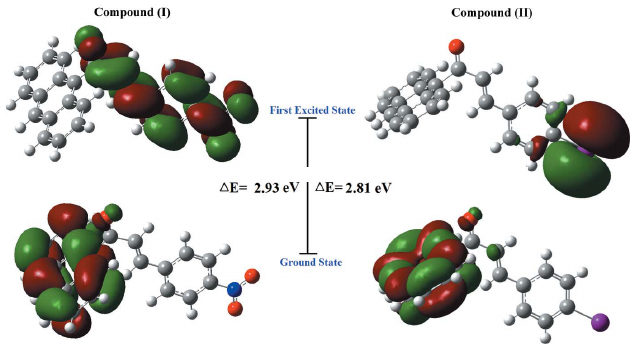
Figure 5 The electron distribution of the HOMO and LUMO energy levels in compounds (I) and (II).